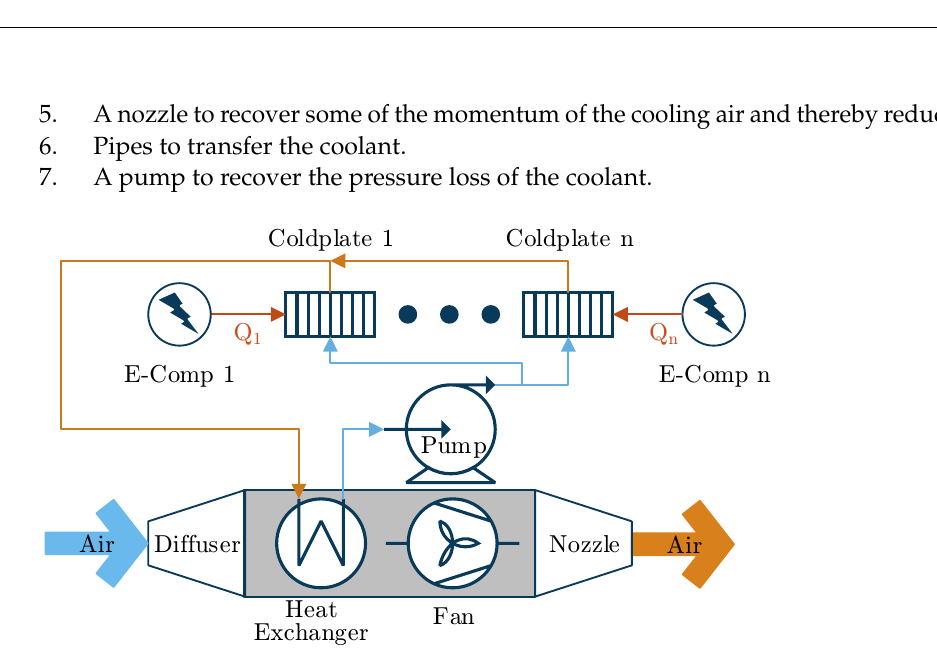
Figure 1. Centralized parallel thermal management system (TMS).